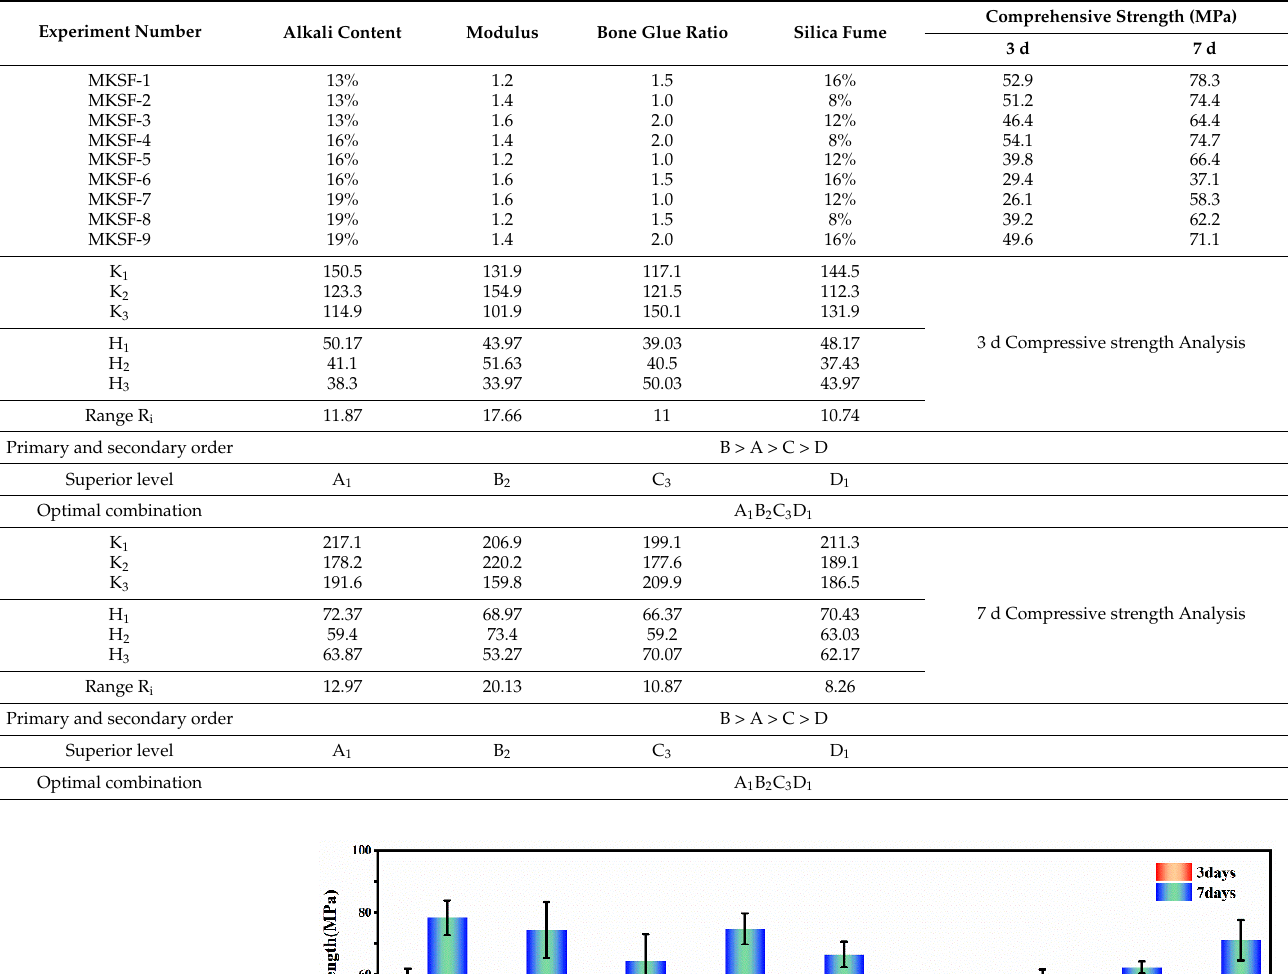
Table 7. Test results and range analysis.